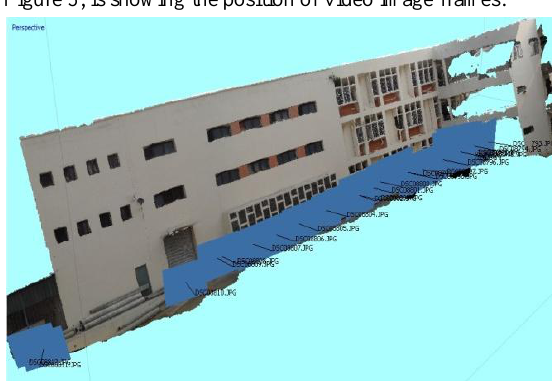
Figure 5, is showing the position of video image frames.